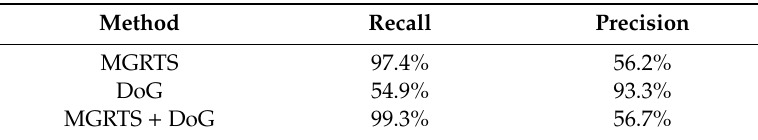
Table 1. Comparison of MGRTS, DoG, and the combination of